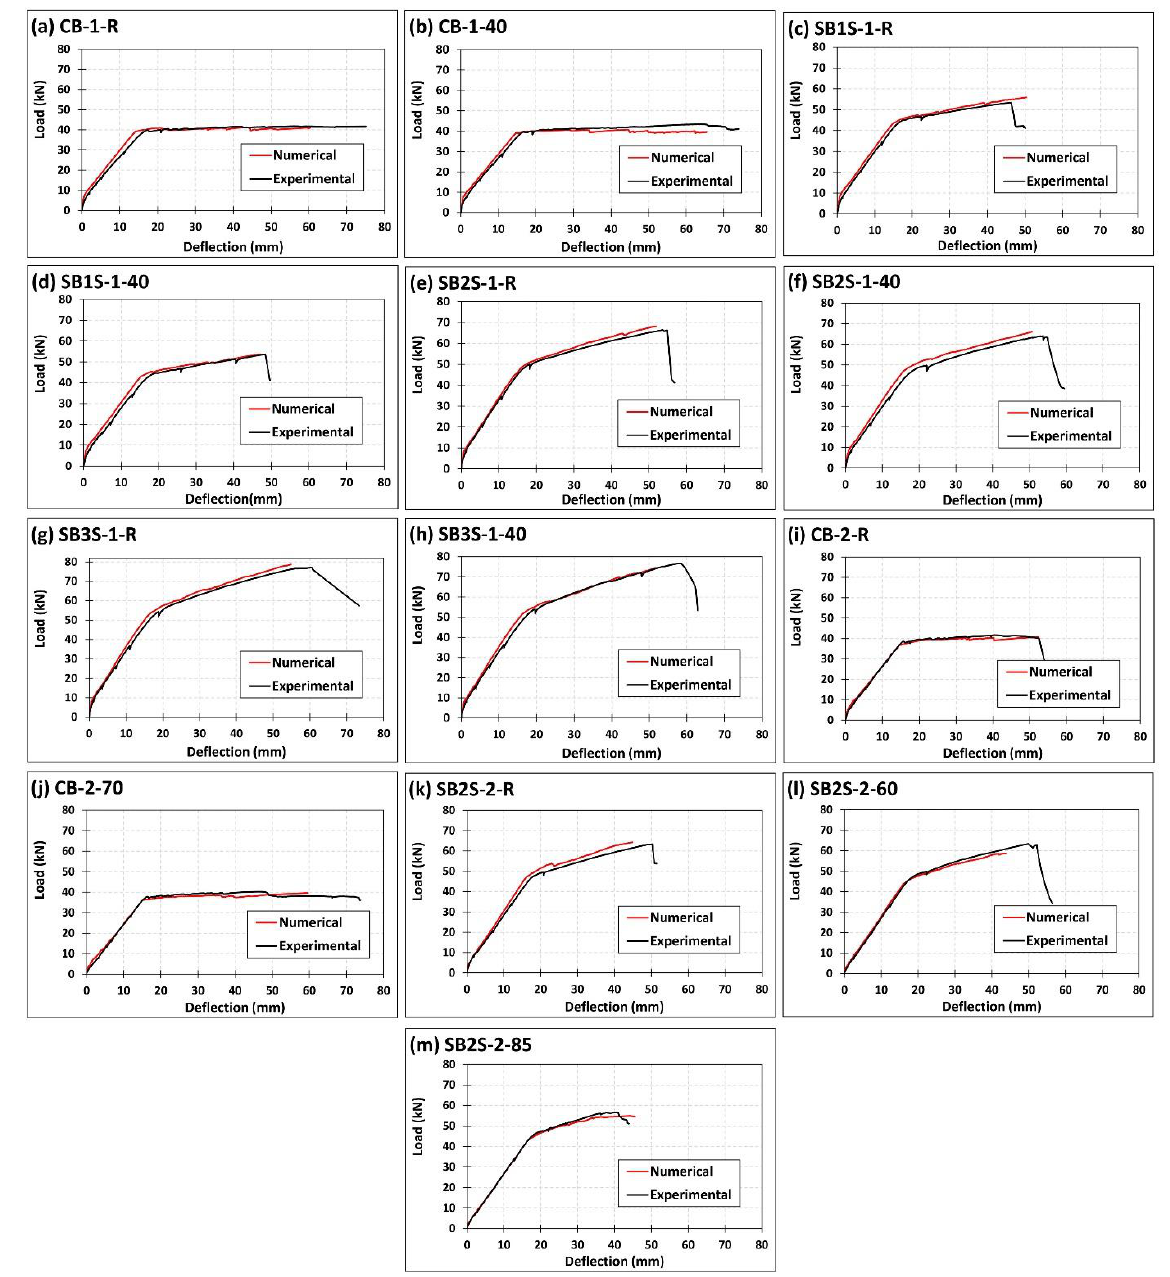
Figure 16. Comparison between experimental and numerical work of specimens ( a ) CB-1-R; ( b ) CB-1-40; ( c ) SB1S-1-R; ( d ) SB1S-1-40; ( e ) SB2S-1-R; ( f ) SB2S-1-40; ( g ) SB3S-1-R; ( h ) SB3S-1-40; ( i ) CB-2-R; ( j ) CB-2-70; ( k ) SB2S-2-R; ( l ) SB2S-2-60; and ( m ) SB2S-2-85.